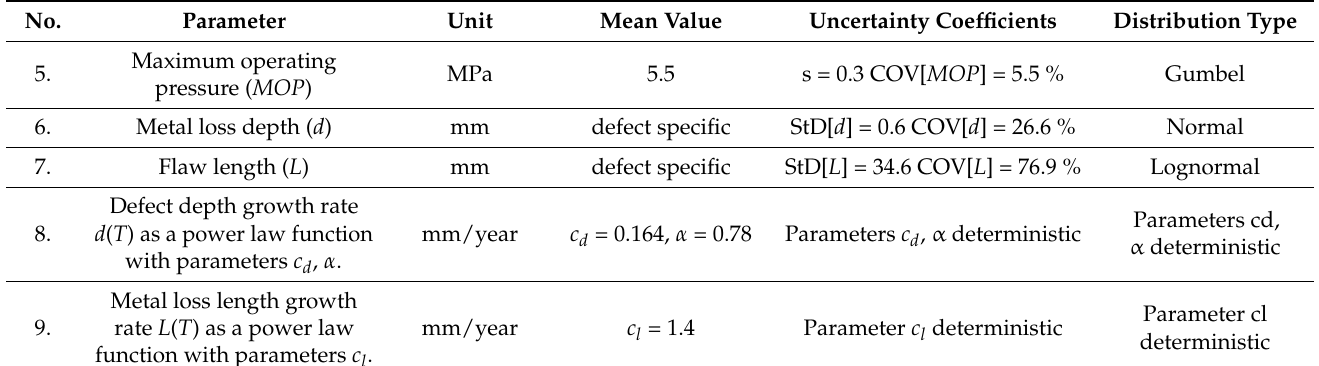
showing the rapid aging effect of the steel buried structure.